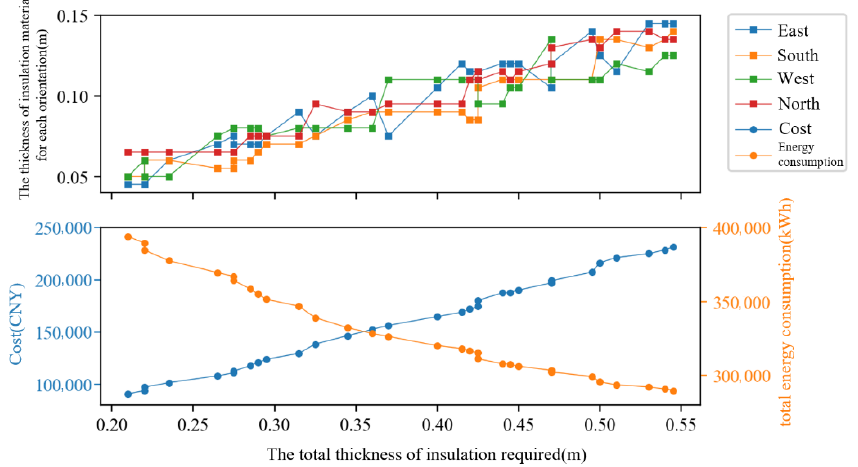
Figure 8. Chart of thickness–total energy consumption–cost.